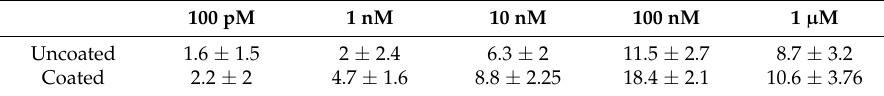
Table 6. Enhancement of cytotoxicity (%) for anastrozole-loaded CA in 4T1.